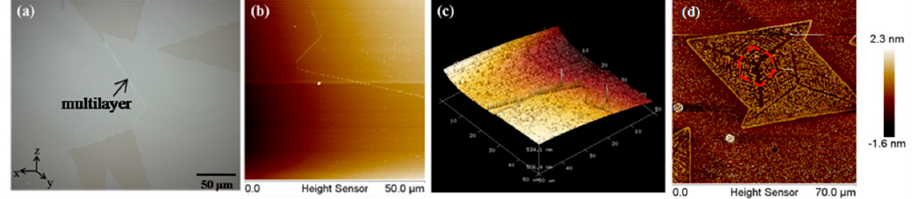
Figure 4. ( a ) optical image on the grain boundary; ( b ) 2D image of the grain boundary by atomic force microscope (AFM); ( c ) 3D image of the grain boundary by AFM; ( d ) outline of the film by AFM.